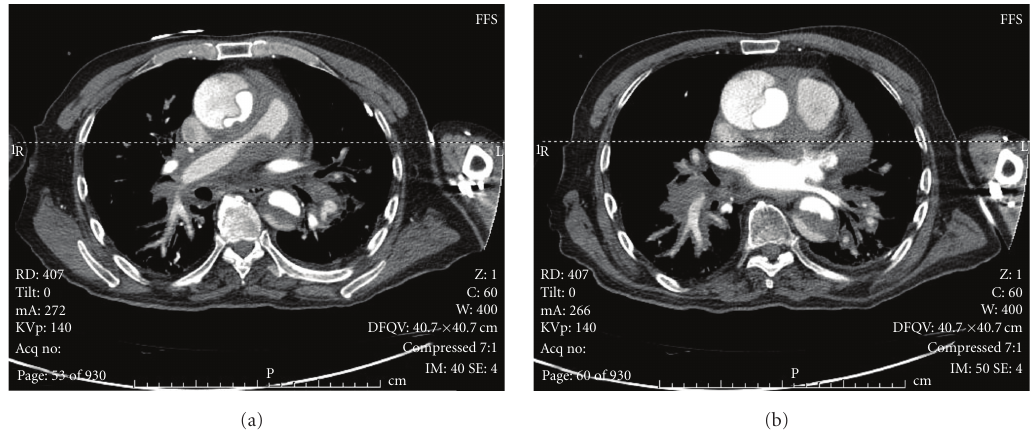
Figure 1: CT scans demonstrate an aortic aneurysm, showing contrast within the true lumen, a pericardial e ff usion, and haemorrhage extending down the pulmonary arteries and veins to subsegmental